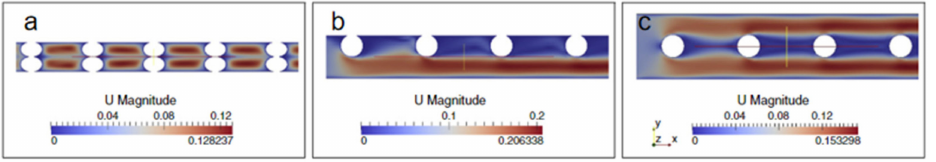
Figure 16. Velocity magnitude (in m/s) color maps on a z-normal plane through center of the domain [33]. Reproduced with permission from Elsevier, 2013. ( a ) spacer type 1; ( b ) spacer type 2; ( c ) spacer type 3.